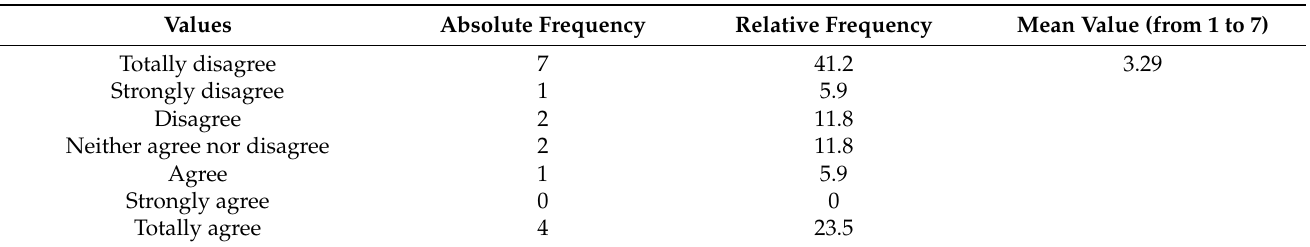
Table 7. Analysis of the results for item 7: “I have not had a mentor (adviser/guide) during my academic and professional career”.